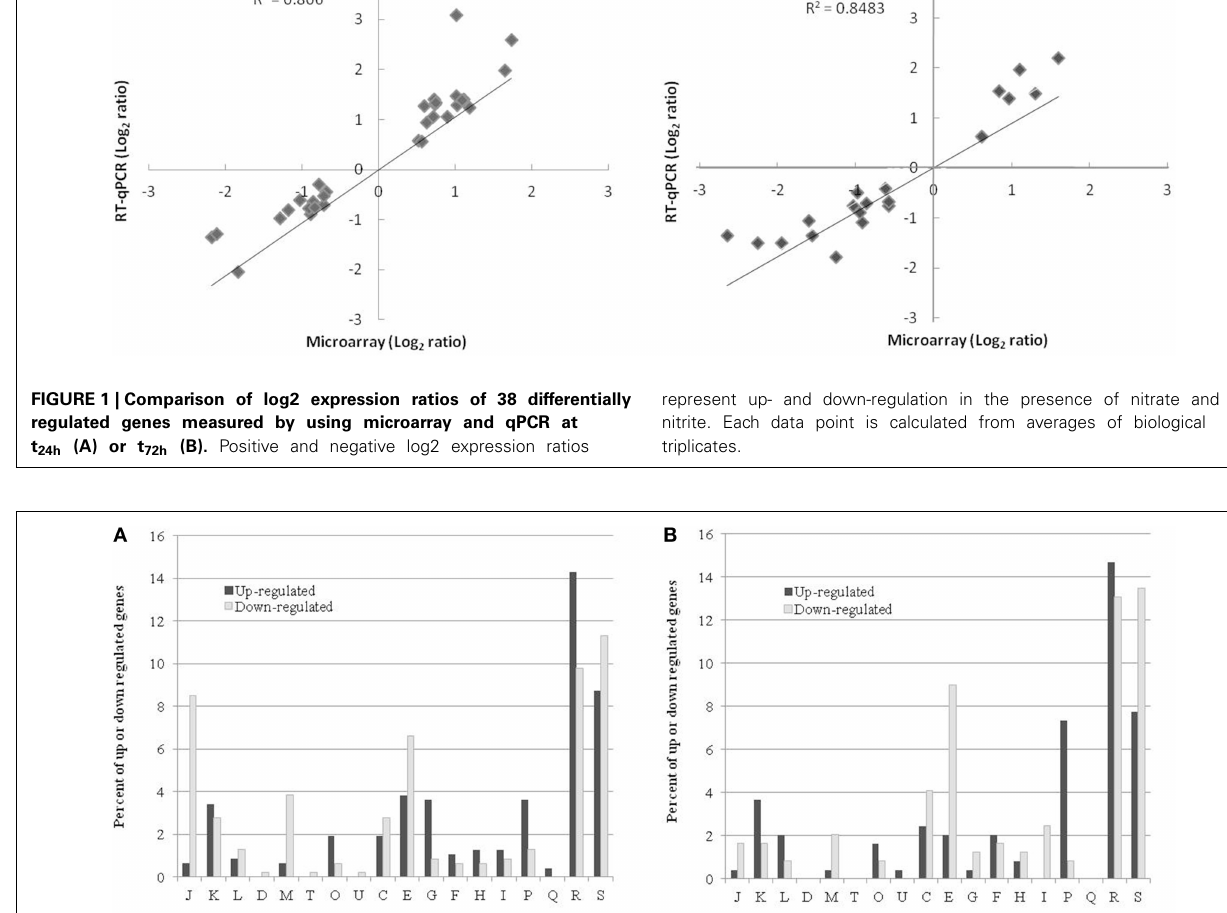
FIGURE 2 | COG distribution of differentially up-and down-regulated genes in the transcriptome at t 24h (A) or t 72h (B). The percentages represent the number of genes that are in a category relative to the respective total number of genes that were up- or down-regulated. The COG abbreviations are as follows: [J] translation, ribosomal structure, and biogenesis; [K] transcription; [L] replication, recombination, and repair; [D] cell cycle control, cell division, and chromosome partitioning; [M] cell wall/membrane/envelope biogenesis; [T] signal transduction mechanisms; [O]